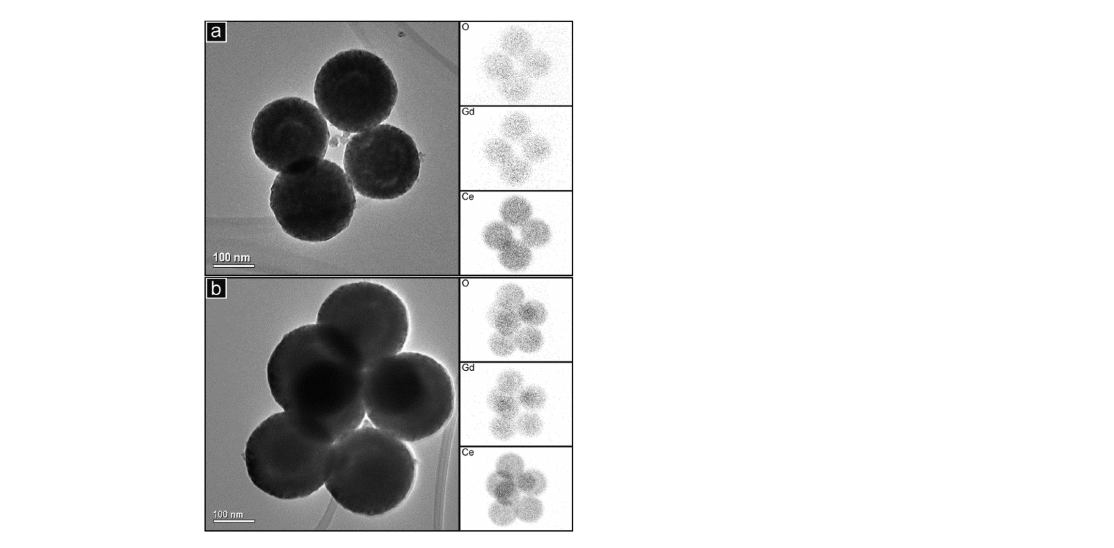
Figure 16. TEM images of groups of spherical particles of gadolinium-substituted CeO 2 prepared in the presence of urea with ( a ) 10% Gd and ( b ) 20% Gd, with corresponding energy-dispersive spec- troscopy maps of the elements shown on the right [121]. Reproduced from Muñoz, F.F.; Acuña, L.M.; Albornoz, C.A.; Leyva, A.G.; Baker, R.T.; Fuentes, R.O. Redox properties of nanostructured